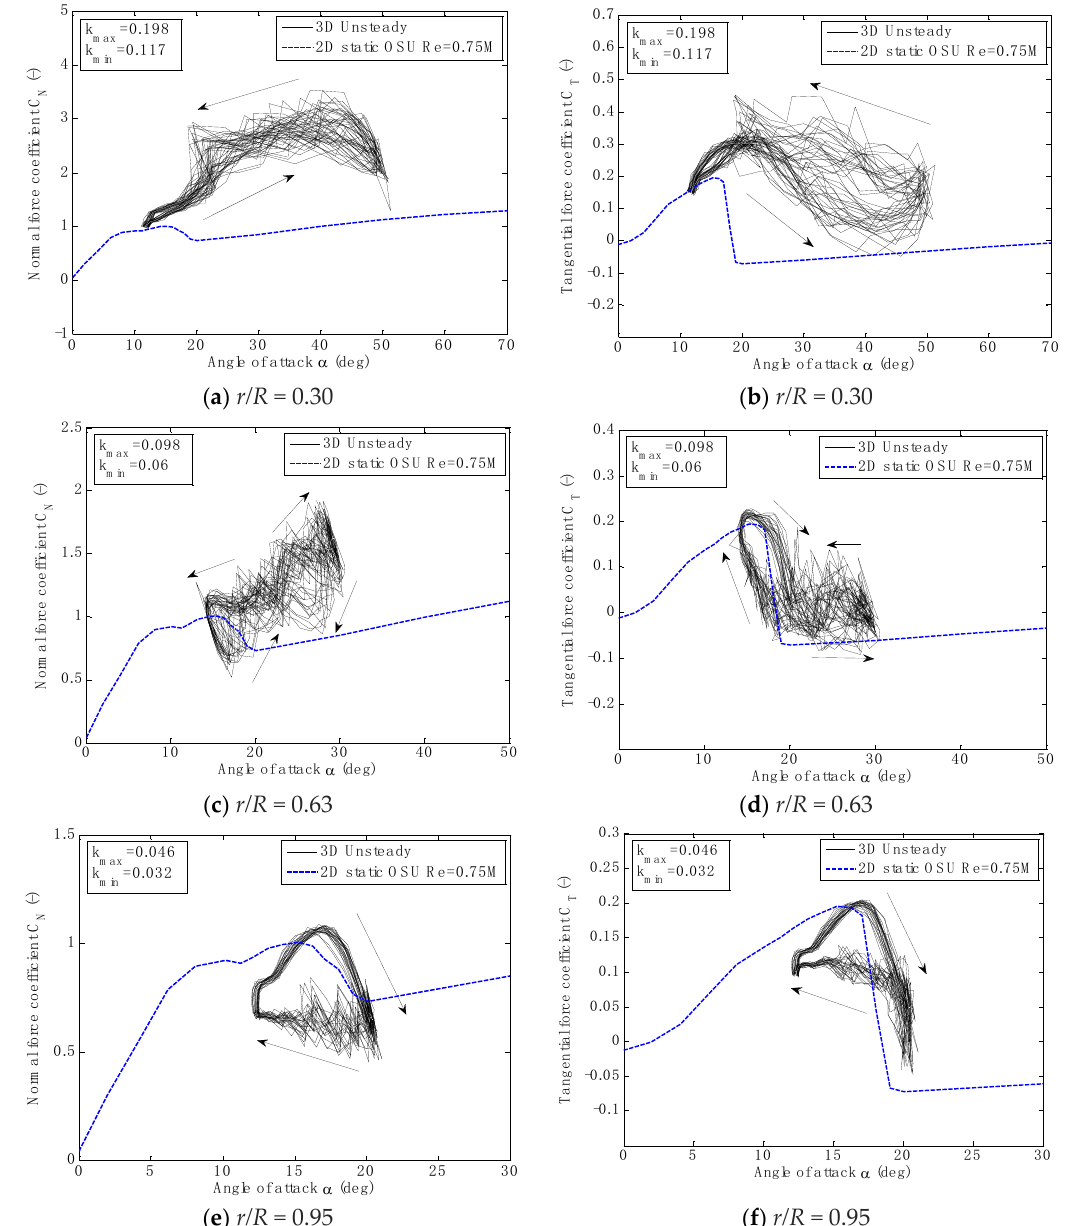
Figure 7. Variation of the unsteady normal and tangential force coefficients against angle of attack for wind speed 15 m/s and yaw angle 30° Solid white lines denote average of C N and C T over 30 rotor rotations, while the black lines indicate the cycle-to-cycle variation in C N and C T over 30 rotor rotations.